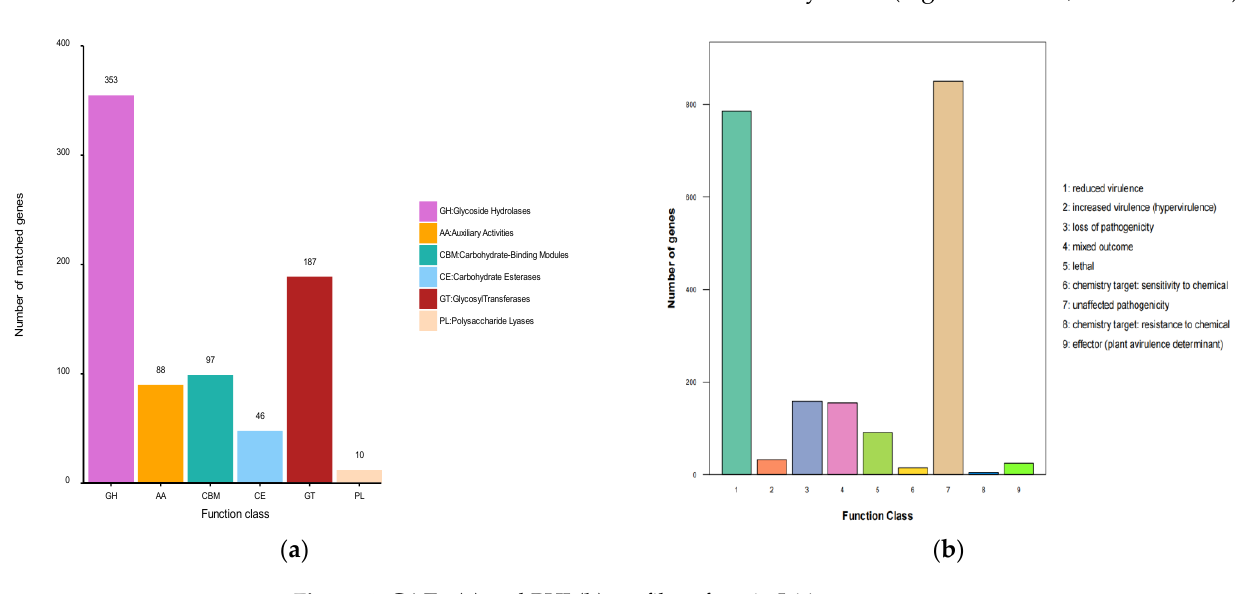
Figure 4. CAZy ( a ) and PHI ( b ) profiles of strain L14.